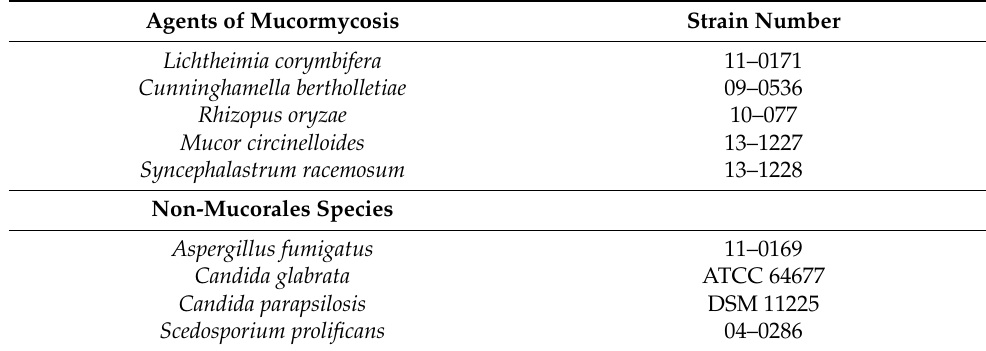
Table 1. Fungal isolates used for experimental evaluation of FISH probes targeting common agents of mucormycosis. All strains were identified by macro- and micromorphology and sequencing of the complete internal transcribed spacer (ITS)